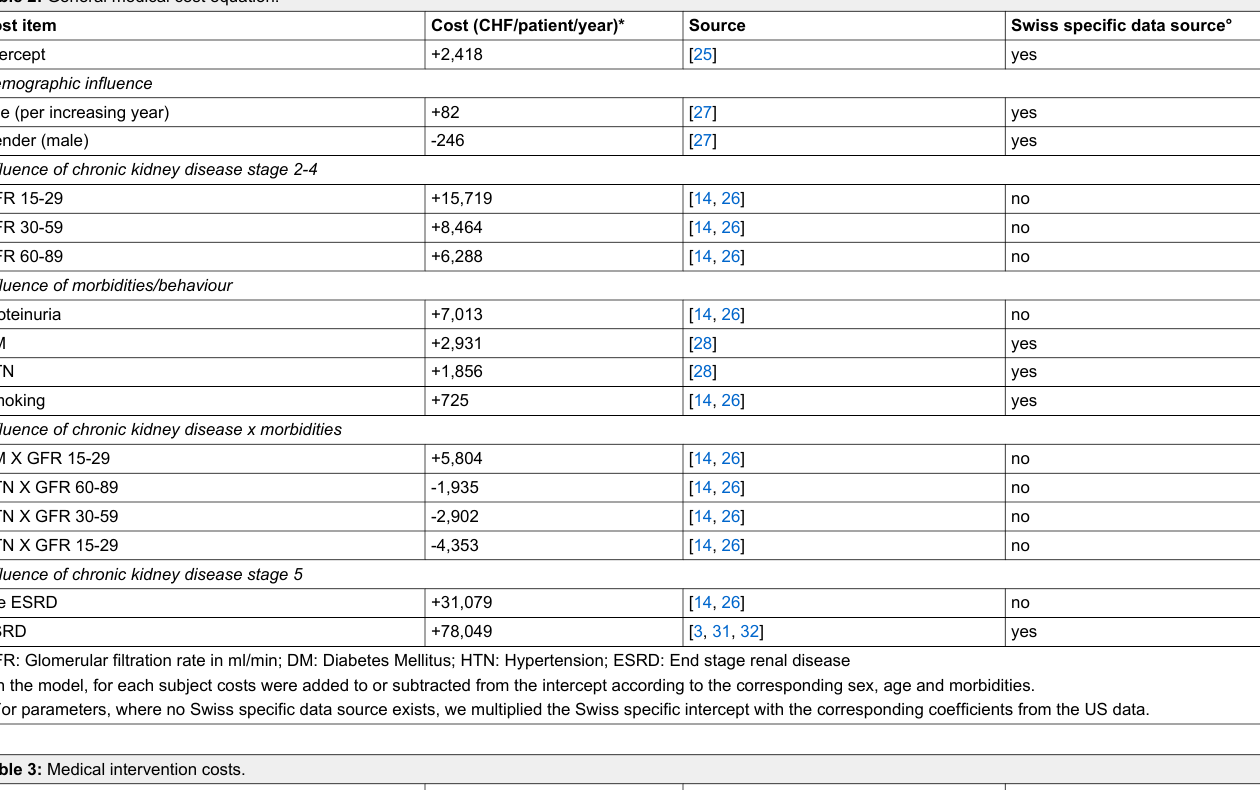
Table 3: Medical intervention